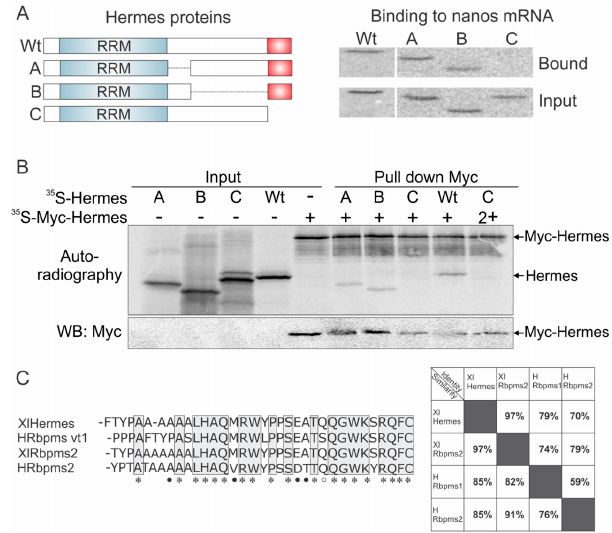
Figure 3. The carboxyl terminal 34 amino acids of Hermes/Rbpms are required for nanos1 binding and for Hermes/Rbpms dimerization. ( A ) Three deletion mutants of Hermes/Rbpms are diagramed showing the RRM domain and the hydrophilic carboxyl terminal 34 amino acids ( red box). 35 S- methionine labeled Hermes/Rbpms and its deletion mutants were analyzed for their ability to be pulled-down by nanos1 3 ′ UTR immobilized on AADA beads. Wild-type and mutant protein (input) used in reaction and bound are shown by SDS-PAGE. Note that only the last 34 amino acids were required for nanos binding in the presence of the Hermes/Rbpms RRM; ( B ) The presence of Hermes/Rbpms homodimers was detected by autoradiography as two bands. Note that Hermes/Rbpms missing the terminal 34 amino acids failed to form a dimer. As nanos RNA was not present, Hermes/Rbpms formed homodimers in the absence of RNA; ( C ) C-terminal region involved in Hermes/Rbpms homodimerization and binding to the nanos 3'UTR. Alignment of conserved terminal 34 amino acids (AA) of Human and Xenopus Hermes/Rbpms proteins. An * (asterisk) indicates a fully conserved AA. Black dots indicate conservation between groups of strongly similar properties (scoring > 0.5 in the Gonnet PAM 250 matrix). A white dot indicates weakly similar properties (scoring ď 0.5 in the Gonnet PAM 250 matrix), Clustal Omega, EMBL-EBI, UK. Table shows the high level of identity and similarity between frog and human Hermes/Rbpms